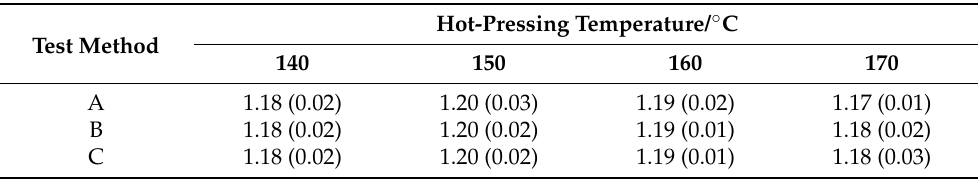
Table 1. The average values and standard deviation of the density of samples. Values in parentheses are the standard